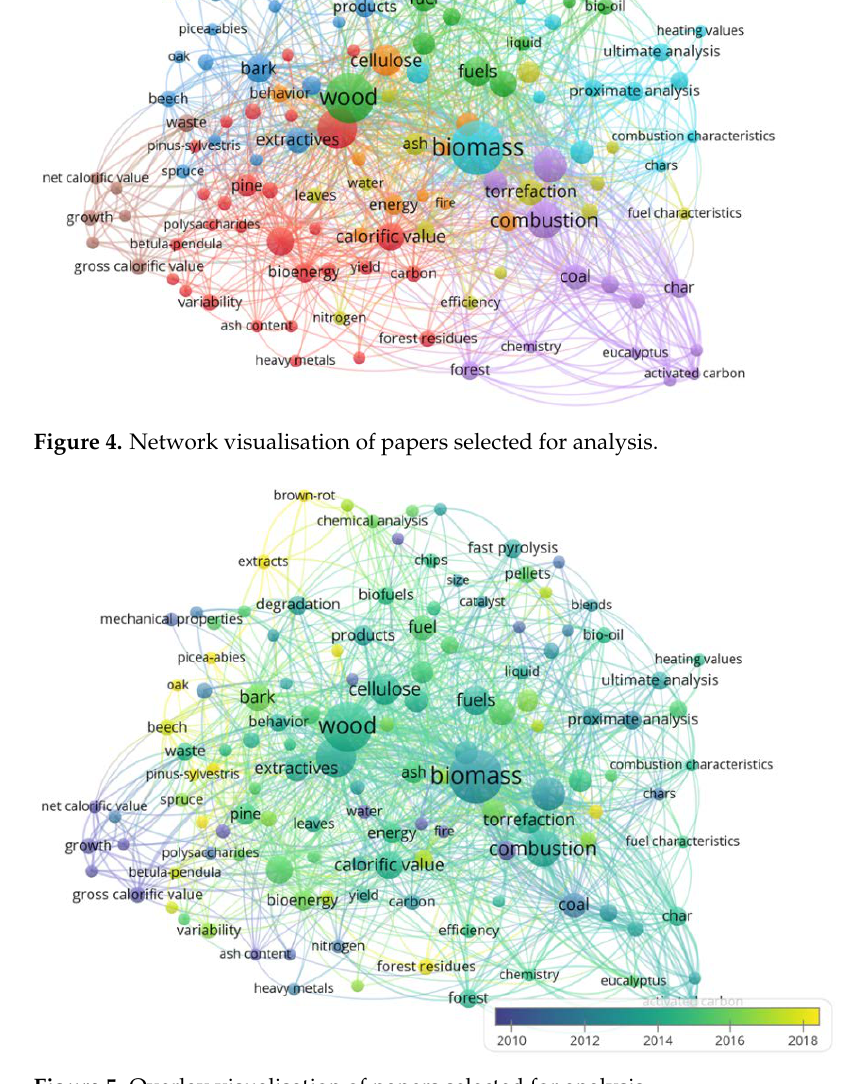
Figure 5. Overlay visualisation of papers selected for